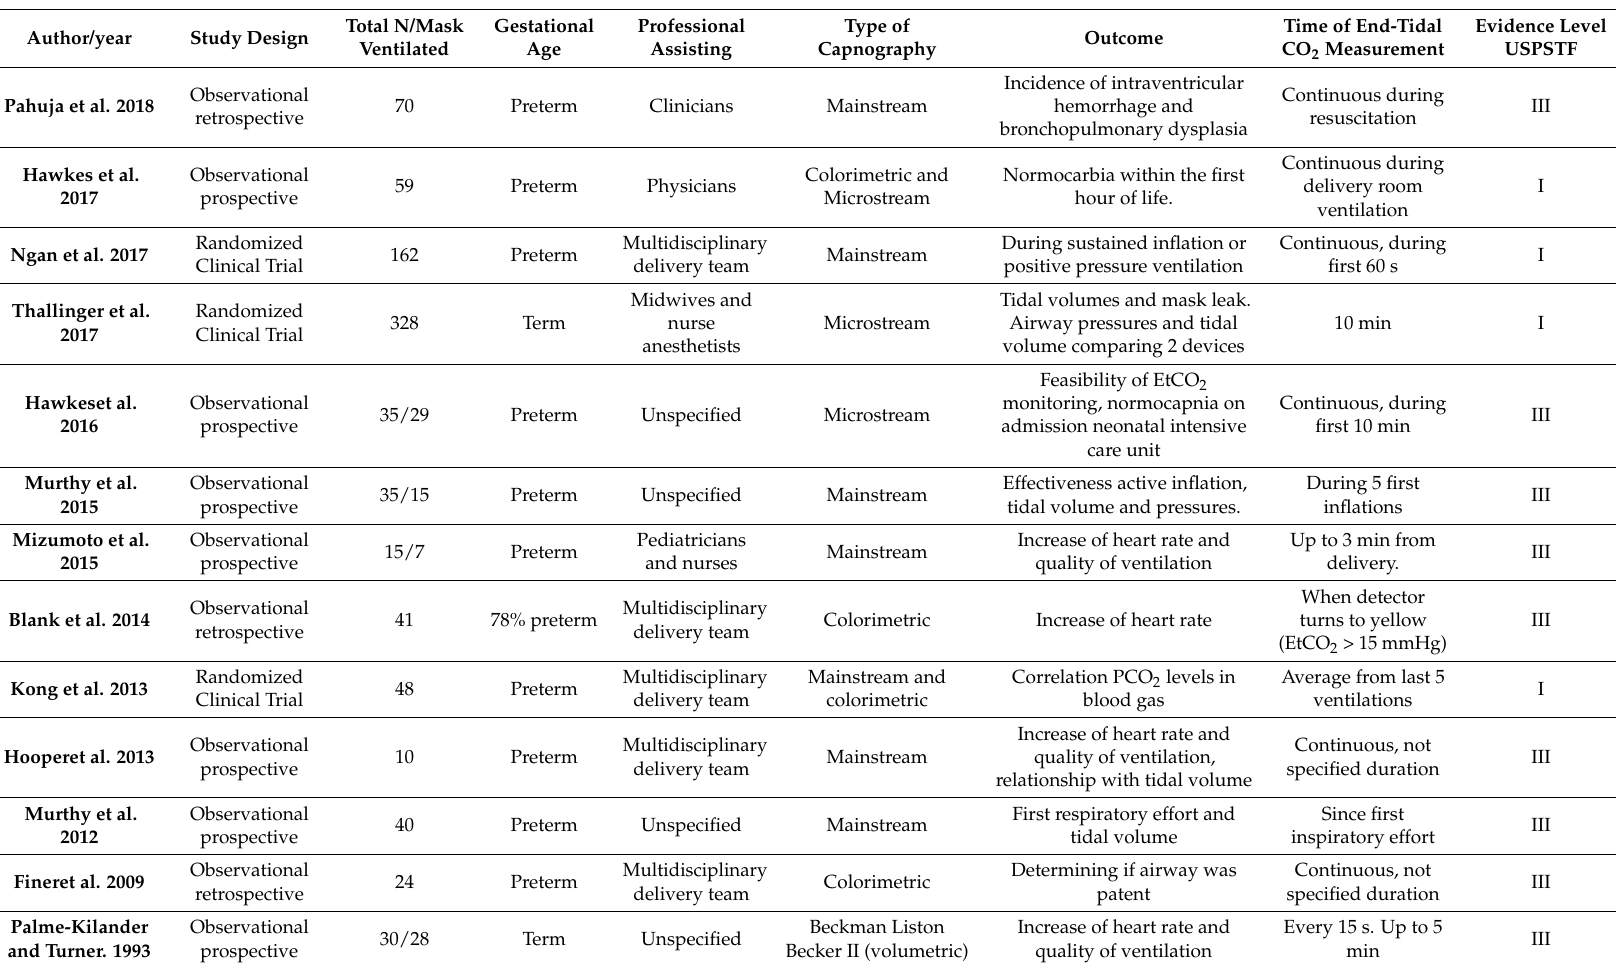
Table 2. Relationship of variables analyzed in the newborn studies, together with evidence levels and evidence level according to